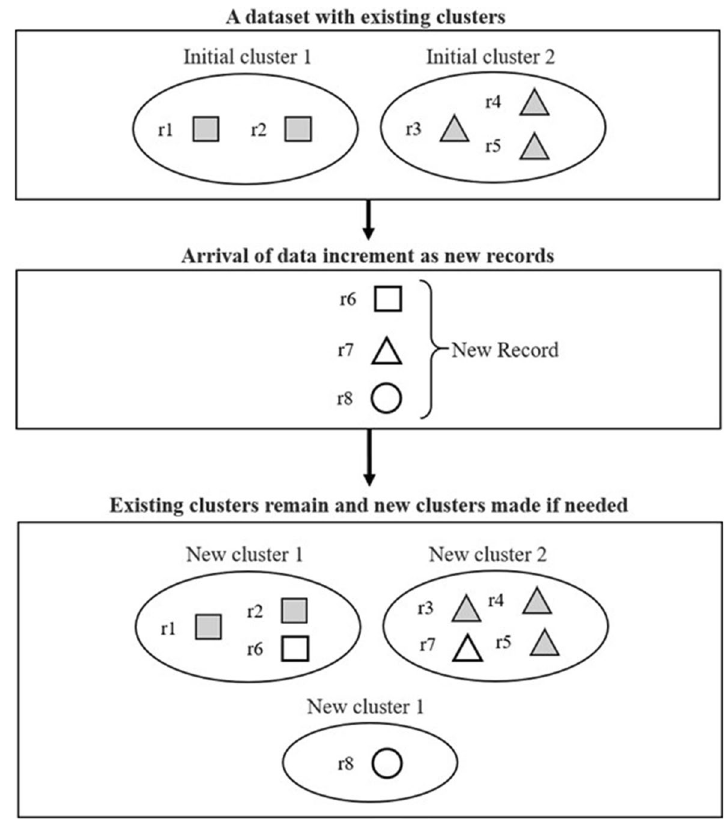
Fig. 4 Stages of incremental record